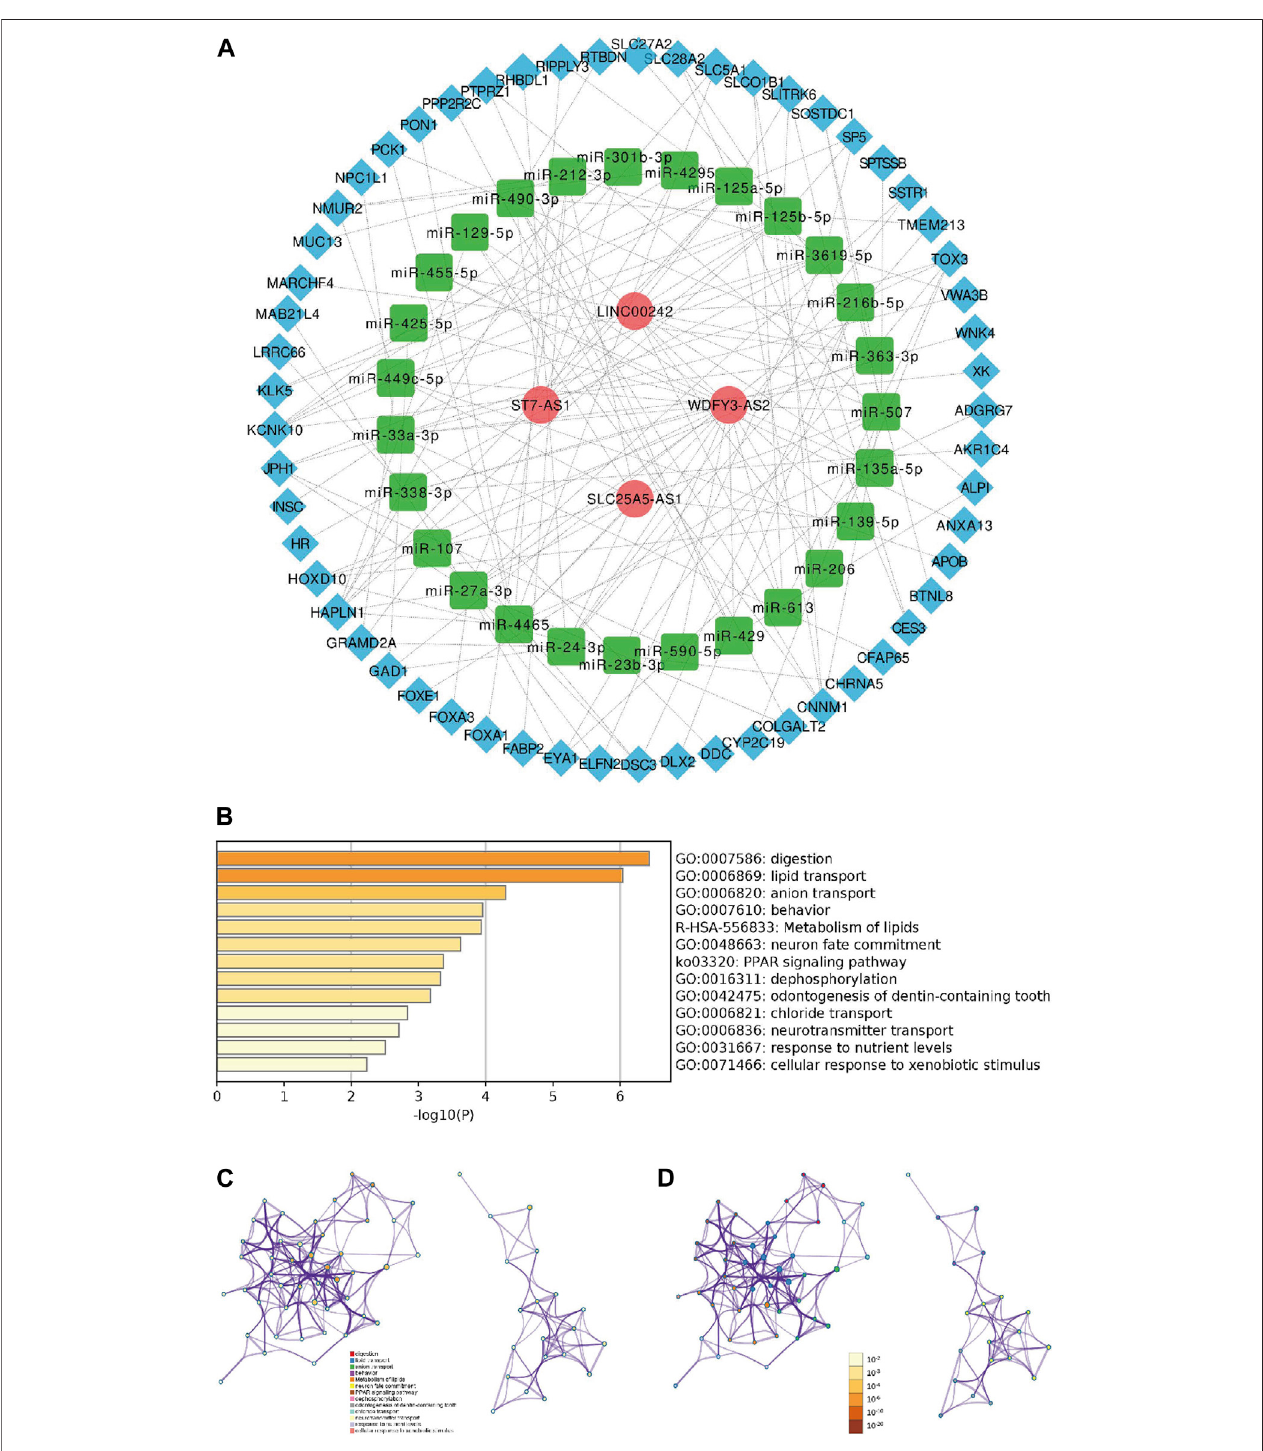
FIGURE8 | AceRNA network including 4lncRNAs-27 miRNAs-57 mRNAswas established (A) . The heatmap (B), cluster ID network (C) and p -value network (D) of enriched pathways based on 57 target mRNAs.